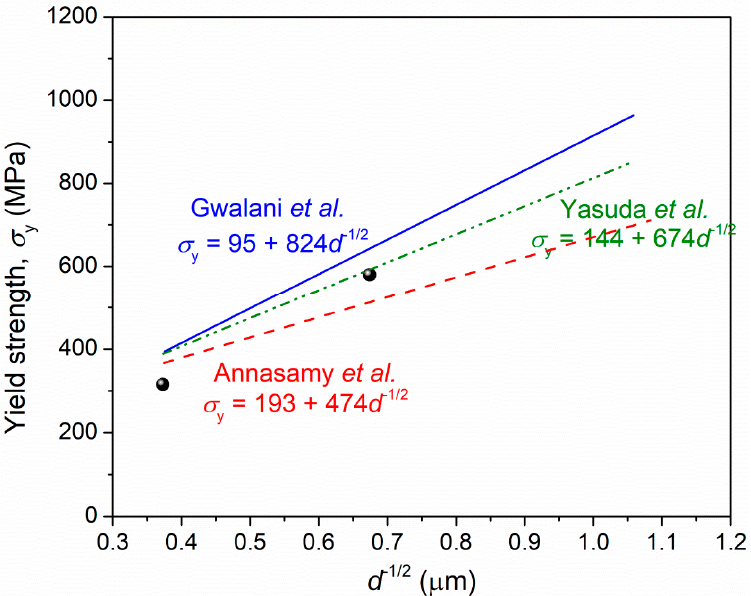
Figure 14. Hall–Petch relationship plotted based on previous references [13,14,16] and the present work data.